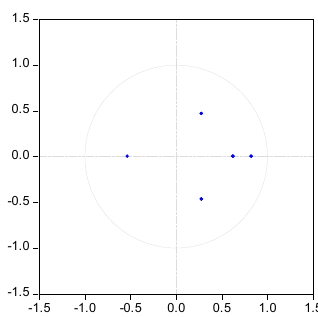
Figure 3. VAR roots of characteristic polynomial of mining and washing of coal. Note: blue dots indicate characteristic roots.